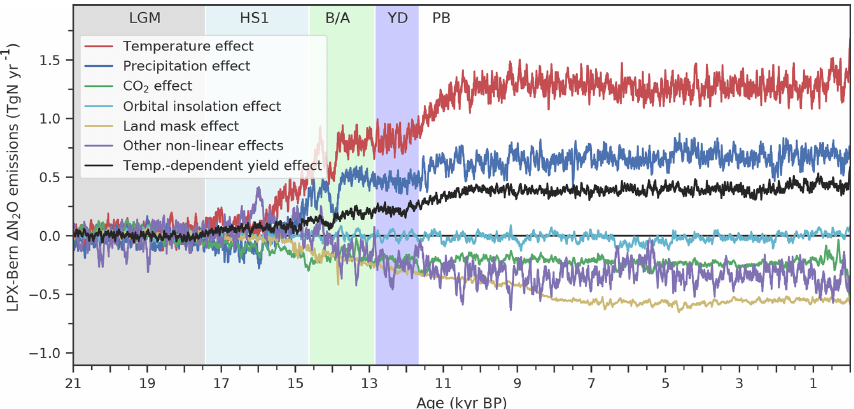
Figure 7. Attribution of simulated global terrestrial N 2 O emission changes to individual drivers. Results are from LPX-Bern(v1.4N) for the standard and factorial simulations, where an individual driver (temperature (red), precipitation (blue), atmospheric CO 2 (green), orbital parameters affecting photosynthetic active radiation (light blue), land mask accounting for sea-level changes) is kept at the preindustrial level. The violet curve (other non-linear effect) is the difference between simulated emissions in the standard setup and the sum of all these attributed emissions; it reflects the effect of non-linear interactions between different drivers. In addition, the black curve indicates the change in N 2 O emissions attributed to variations in the N 2 O yield factor for nitrification and